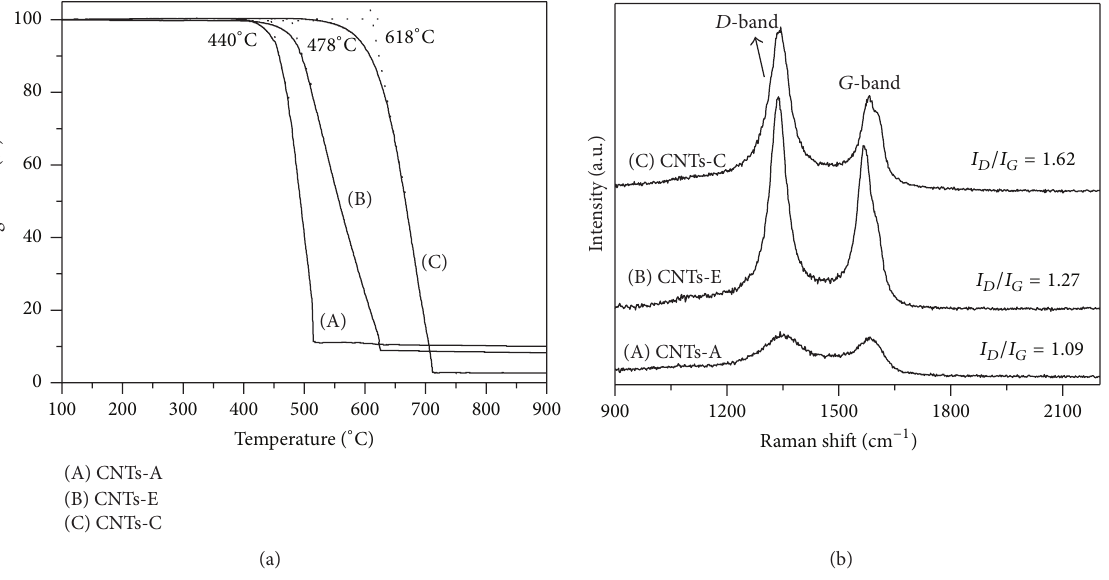
Figure 2: TG curves (a) and Raman spectra (b) of the CNTs samples.